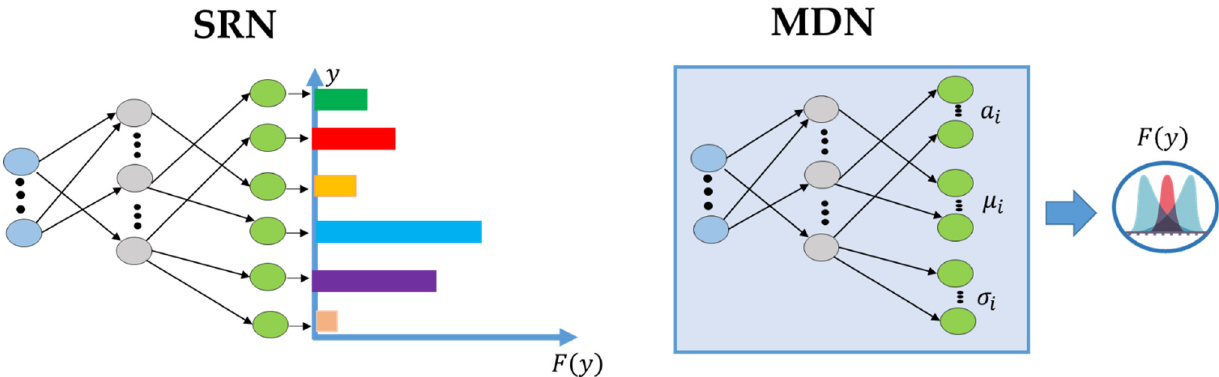
Figure 3. Examples of the network architectures related to two ANN-based probabilistic forecasting models.